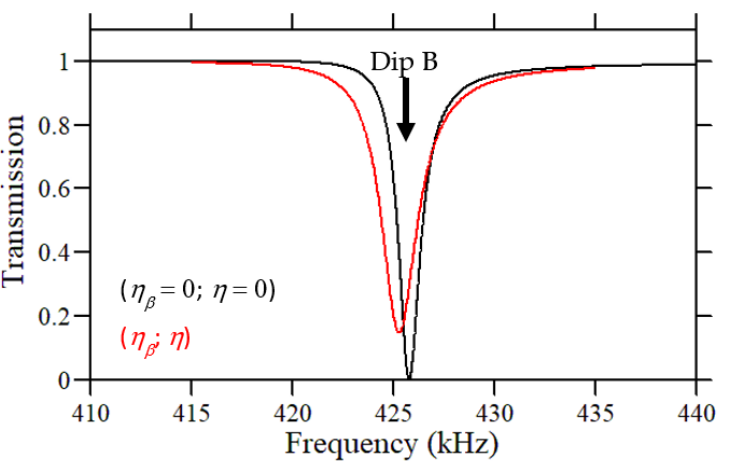
Figure 3. Transmission curves calculated in the vicinity of dip B. The black and red curves correspond to the transmission curves without and with the water viscosity, respectively.